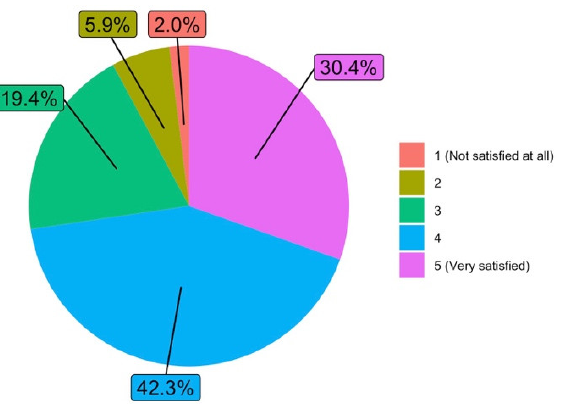
Figure 7. Degree of satisfaction with the work carried out as a teacher during the lockdown period (answers to Q8). (answers to Q8).